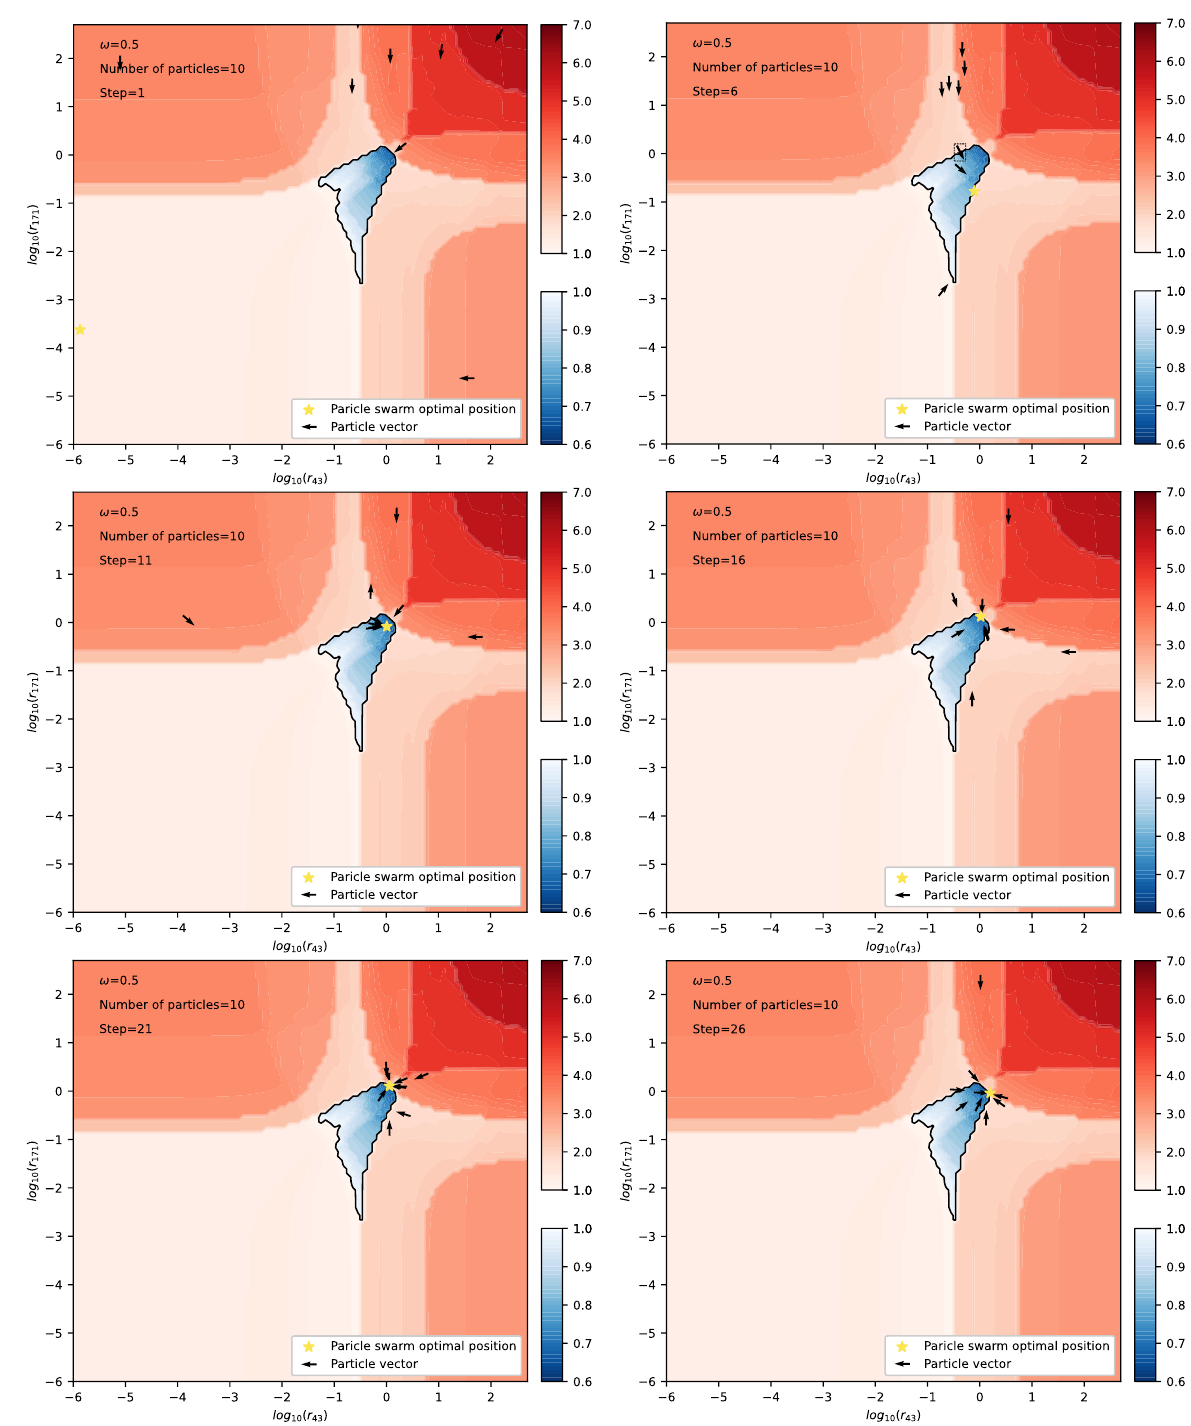
Figure 8. Fitness contour and particle trajectory of BBPSO-Para-Improved. When iteration begins, the particle distribution is dispersed. When iteration contin- ues, the optimal value of the population is constantly updated. All particles gravitate to the center of the particle ’ s optimal value and the population ’ s optimal value and cluster around the optimal global value. The improvement to the optimization strategy proposed in this study allows the feasible region to be entered in fewer epochs, and the optimal global value can be searched in approximately 30 epochs. Figure 9 shows the fitness curves of the five methods. The points in the figure repre- sent the mean, and the strips represent the standard deviation. BBPSO-Para-Improved